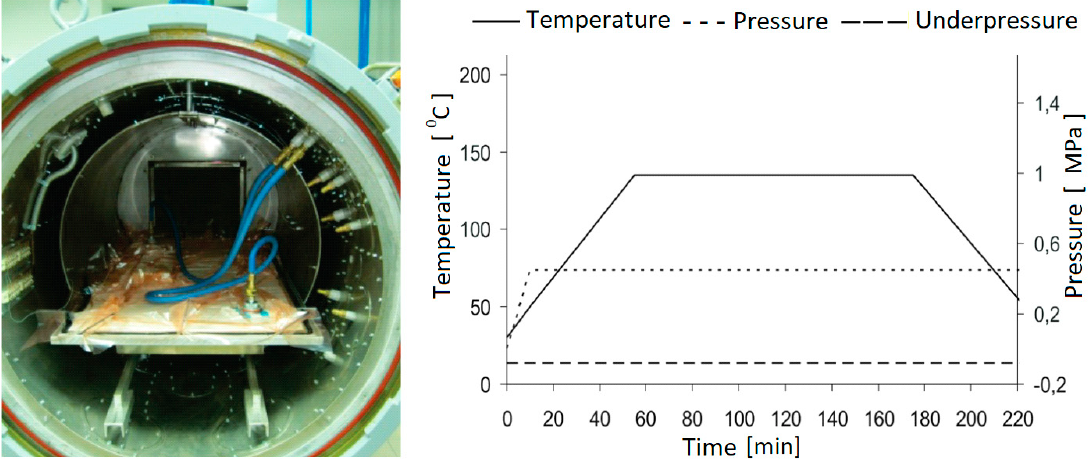
Figure 1. Manufacturing process.